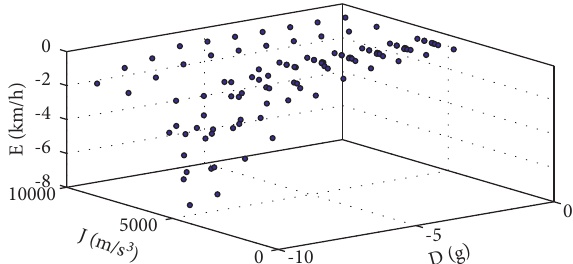
Figure 12: Velocity variation error-mean absolute acceleration slope-discrimination threshold relationship diagram.